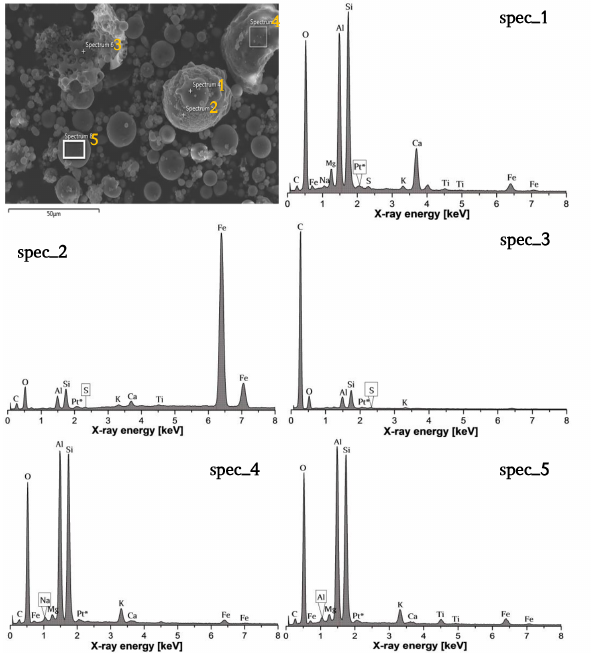
Figure 4. Elemental composition of CFA measured by energy dis- persive X-ray spectroscopy (EDX) that was coupled to a scanning electron microscope (SEM). Platinum / palladium (Pt / Pd) mixture was used to coat the samples before SEM/EDX spectra were taken; hence, it is asterisked on the spectra. These spectra were back- ground corrected before making this plot. The ordinate (which is not shown) is intensity, in counts per second per energy unit (cpseV − 1 ) . The spectra labels (spec_1, spec_2, ..., spec_ n ) on the SEM images are the locations from which the EDX scanned. EDX spectra for the bottom ash samples are given in the